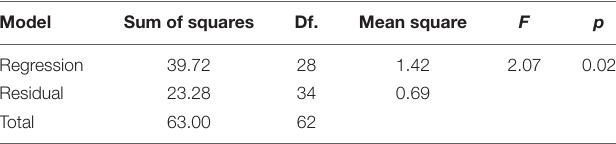
TABLE 7 | ANOVA table.